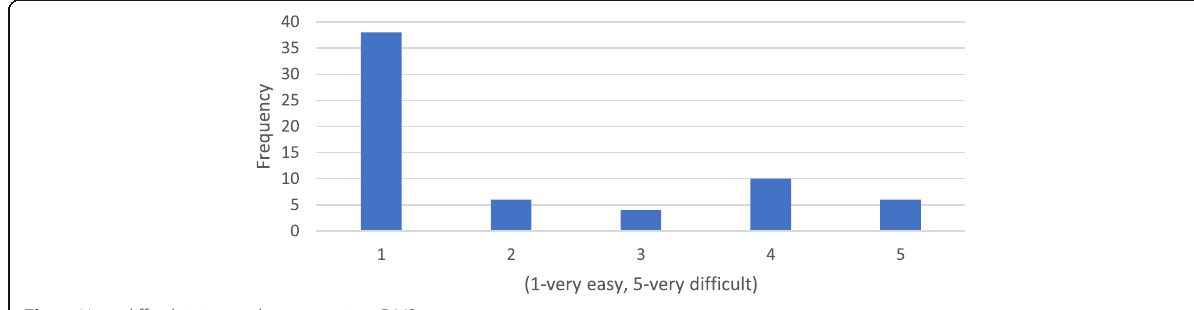
Fig. 1 How difficult is it to take scans using